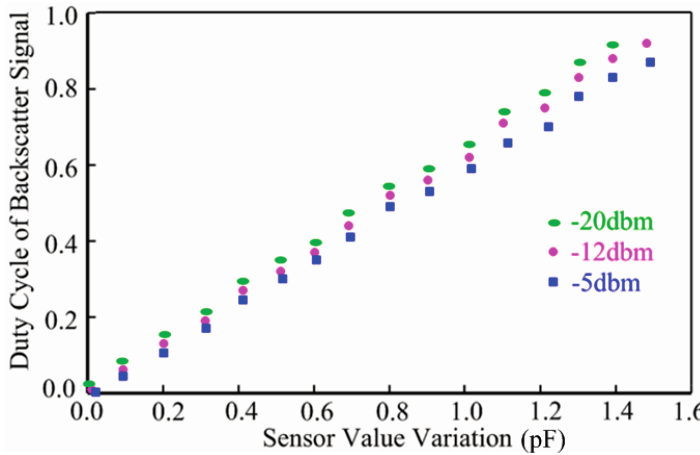
Figure 12. Duty cycle of backscatter signal vs. sensor value variation.